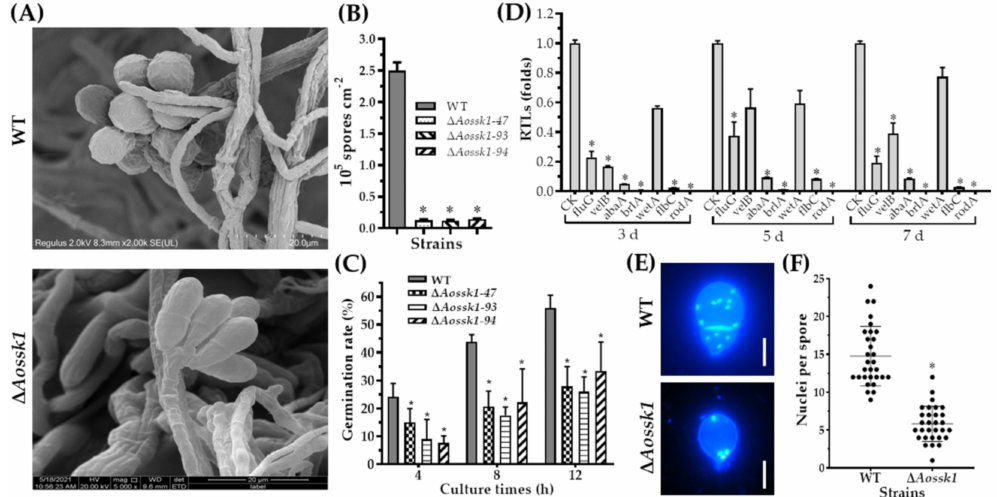
Figure 4. Comparison of conidiation and transcript levels in sporulation-related genes between WT and ∆ Aossk1 mutant strains. ( A ) Spore morphologies of WT and ∆ Aossk1 mutant strains were observed by scanning electron microscopy. ( B ) Conidial yields of WT and ∆ Aossk1 mutant strains. ( C ) Conidial germination rate of WT and ∆ Aossk1 mutant strains. ( D ) Comparison of relative transcript levels (RTLs) of sporulation-related genes between ∆ Aossk1 mutant and WT strain on the 3rd, 5th, and 7th days. CK (which has an RTL of 1) was used as a standard for the statistical analysis of the RTL. An asterisk ( B – D ) indicates a significant difference between ∆ Aossk1 mutant and WT strain (Tukey’s HSD, p < 0.05). ( E ) Observation of cell nuclei in the conidia of WT and ∆ Aossk1 mutant strains. Bar = 10 µ m. ( F ) Comparison of cell nuclei in the conidia of WT and ∆ Aossk1 mutant strains. An asterisk indicates a significant difference between ∆ Aossk1 mutant and the WT strain (n = 30, Tukey’s HSD, p <